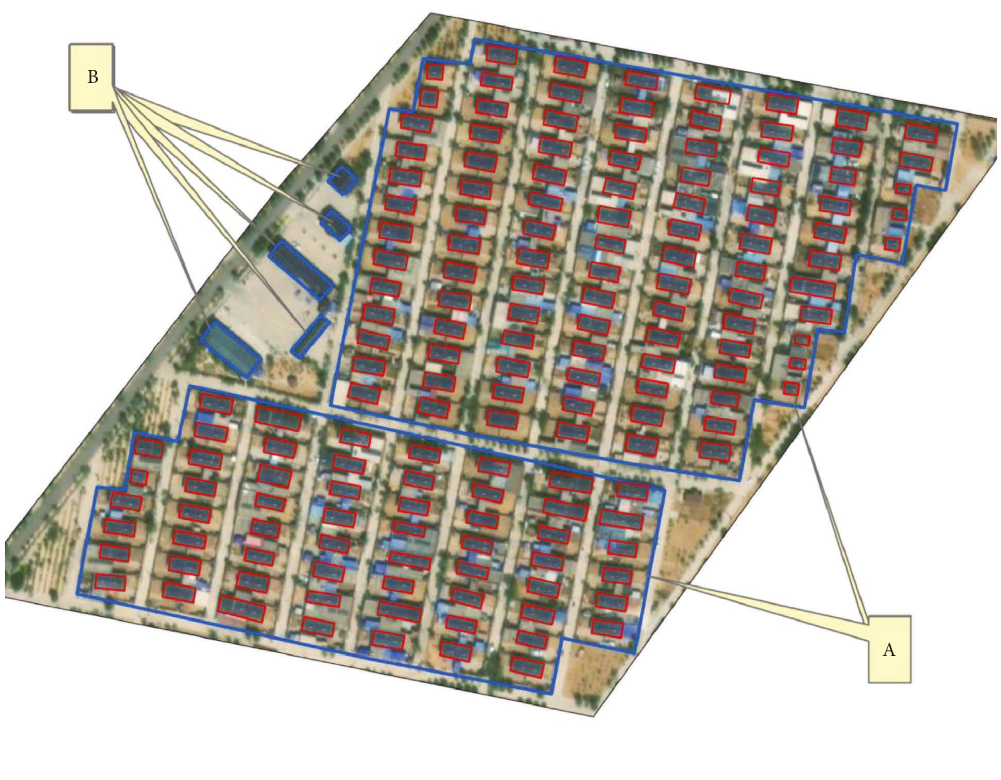
Figure 6: Visually interpreted GS building block and standalone building